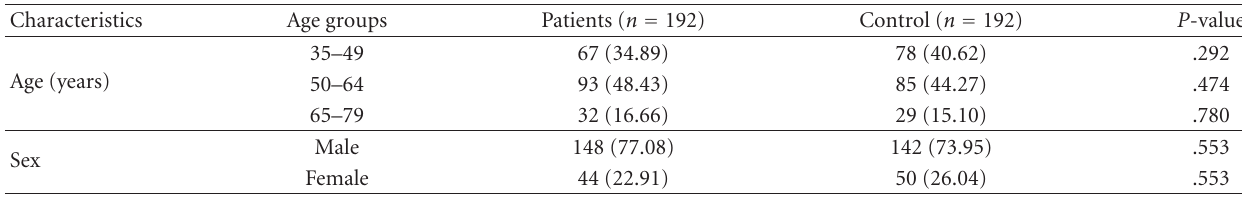
Table 1: Characteristics of coronary artery disease patients and controls.